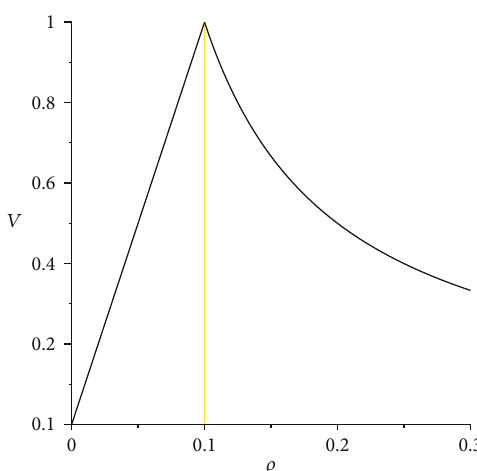
Figure 1: Speed of the vanishing Poynting vector observers for a rigidly rotating magnetic dipole. Inside the light cylinder, ϱ < 0 : 1 , the electromagnetic fi eld is of the pure magnetic type and rotates rigidly with a subluminal speed v < 1 , on the light cylinder, ϱ = 0 : 1 , the fi eld is of the pure null type and rotates with the speed of light, and outside the light cylinder, ϱ > 0 : 1 , the electromagnetic fi eld is of the pure electric type and rotates di ff erentially with a subluminal speed. Here, ϱ is the cylindrical radial